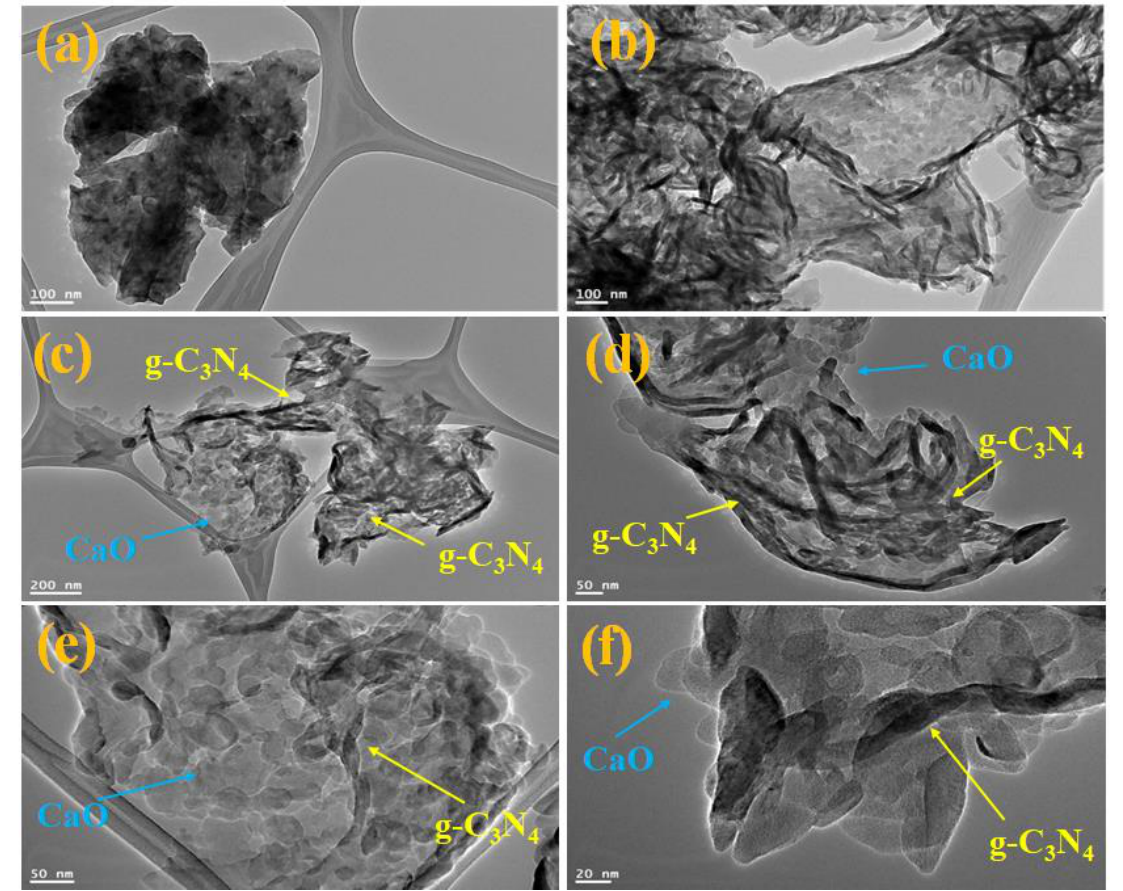
Figure 2. TEM images of ( a ) CaO, ( b ) g-C 3 N 4 , and ( c – f ) CaO-g-C 3 N 4 nanosorbent with different magnifications.